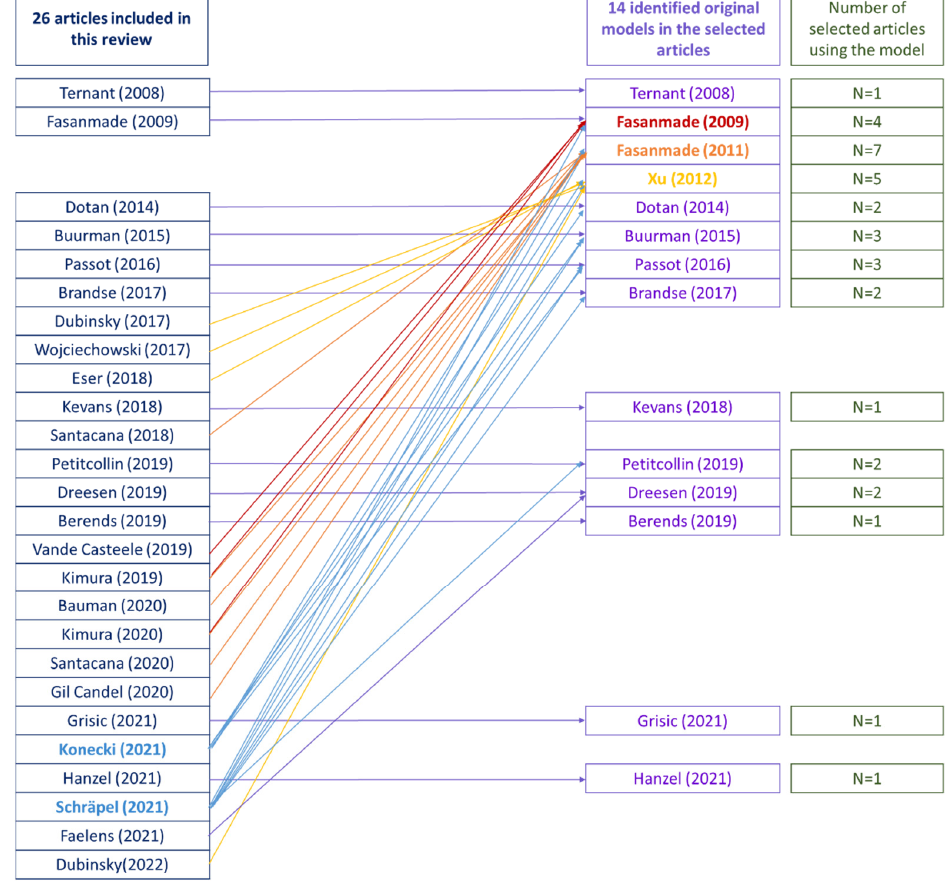
Figure 3. Scheme of the 26 selected articles linked to one or several of the identified original models. Arrows link the selected articles to the original model used in their study. Konecki (2021) [60] and Schräpel (2021) [61], in blue, are displayed in a different colour, as their studies consisted in evaluated published models, thus including several original models in their publication. Fasamnade (2009) [49], in red, Fasanmade (2011) [64], in orange, and Xu (2012) [65] in yellow are displayed in different colours, as their original models were extensively re-used in studies from the selected articles.